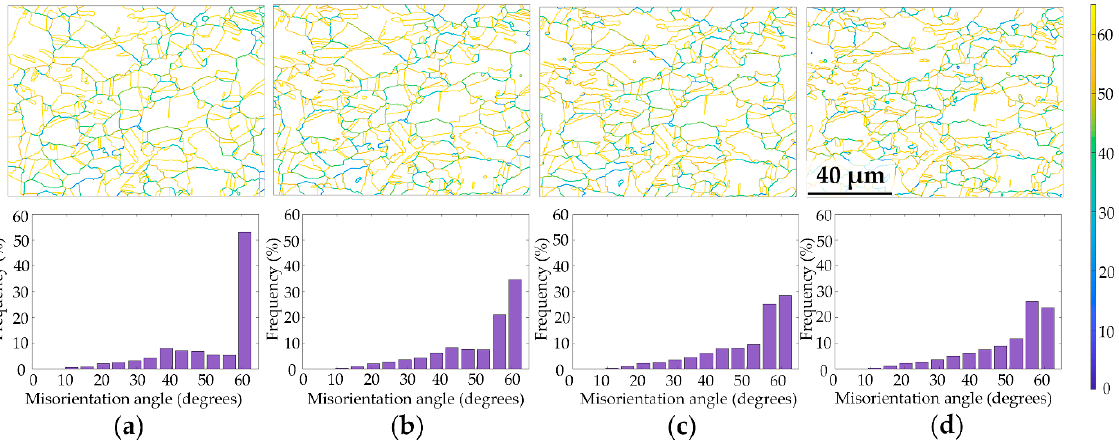
Figure 5. Evolution of the misorientation angle la rger than 15° at strains of ( a ) 0%, ( b ) 12%, ( c ) 18% and ( d ) 24%.